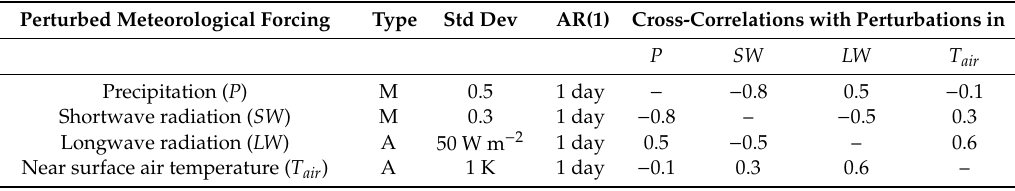
Table 2. Perturbation parameters applied to meteorological forcing fields for both the OL and DA cases (M: multiplicative; A: additive; AR(1): first-order autoregressive temporal correlation). Perturbed Meteorological Forcing Type Std Dev AR(1) Cross-Correlations with Perturbations in P SW LW T air Precipitation ( P ) M 0.5 1 day − − 0.8 0.5 − 0.1 Shortwave radiation ( SW ) M 0.3 Longwave radiation ( LW ) Near surface air temperature ( T air ) A